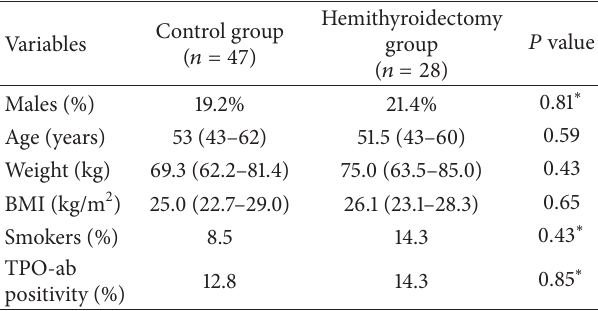
Table 2: Comparison between study groups at baseline.